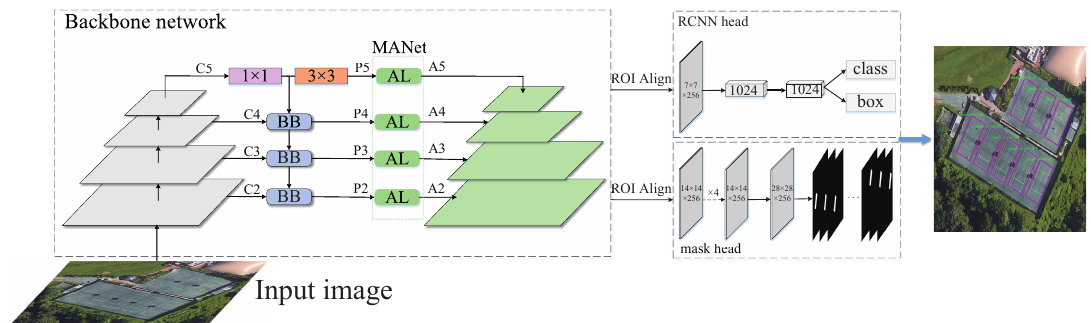
Figure 2. The overall framework of RADet. BB denotes the building block of Refine Feature Pyramid Network. AL denotes the attention layer of MANet (Multi-layer Attention